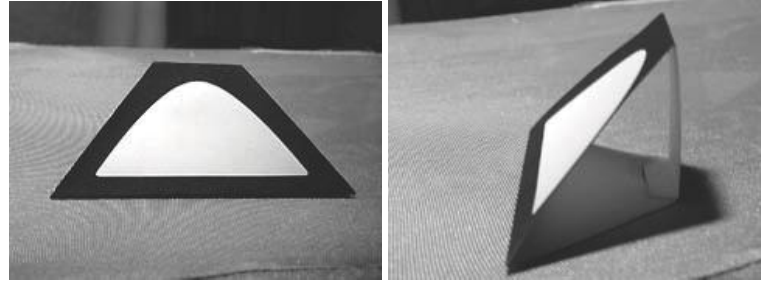
Figure 2. Visual pattern used in the Cachya head tracking